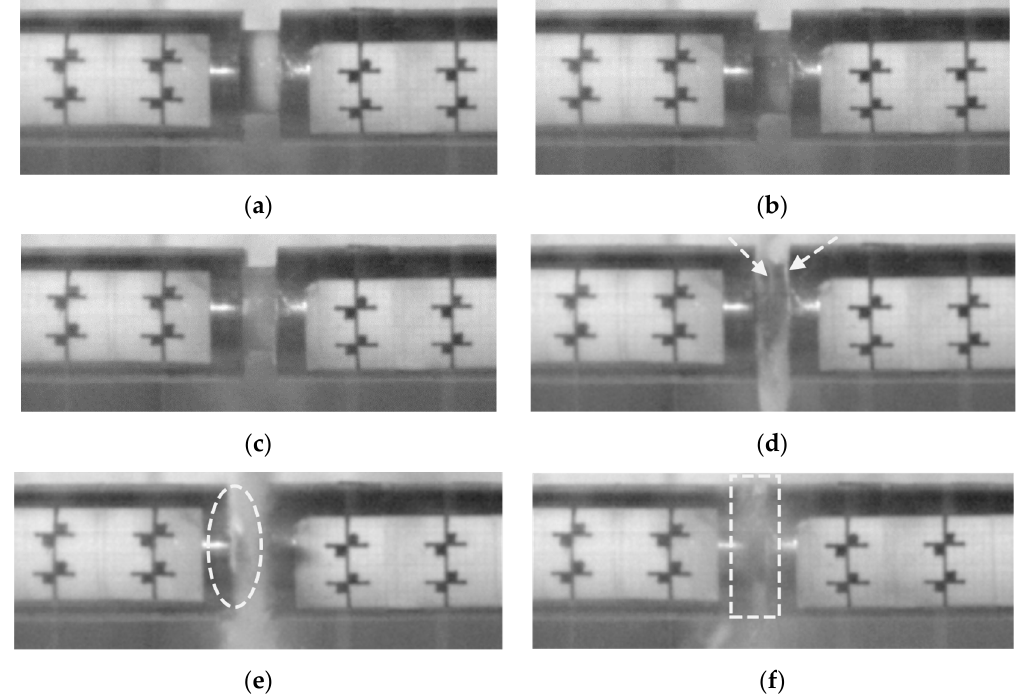
Figure 9. The failing process of the specimen under out-of-plane loading: ( a ) 0 µ s; ( b ) 20.8 µ s; ( c ) 31.2 µ s; ( d ) 56.16 µ s; ( e ) 126.88 µ s; ( f ) 520 µ s.